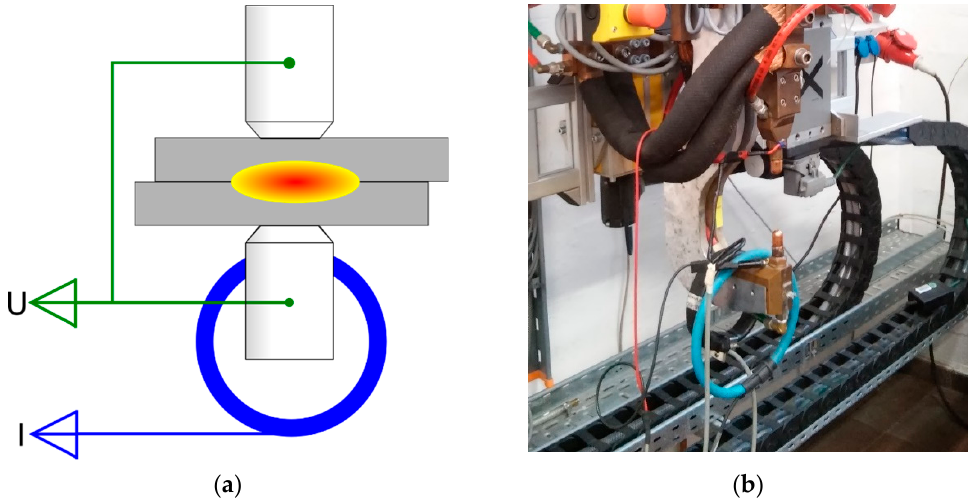
Figure 1. Experimental setup. ( a ) Schematic of the welding setup; ( b ) footage of the welding gun with a Rogowski coil and voltage